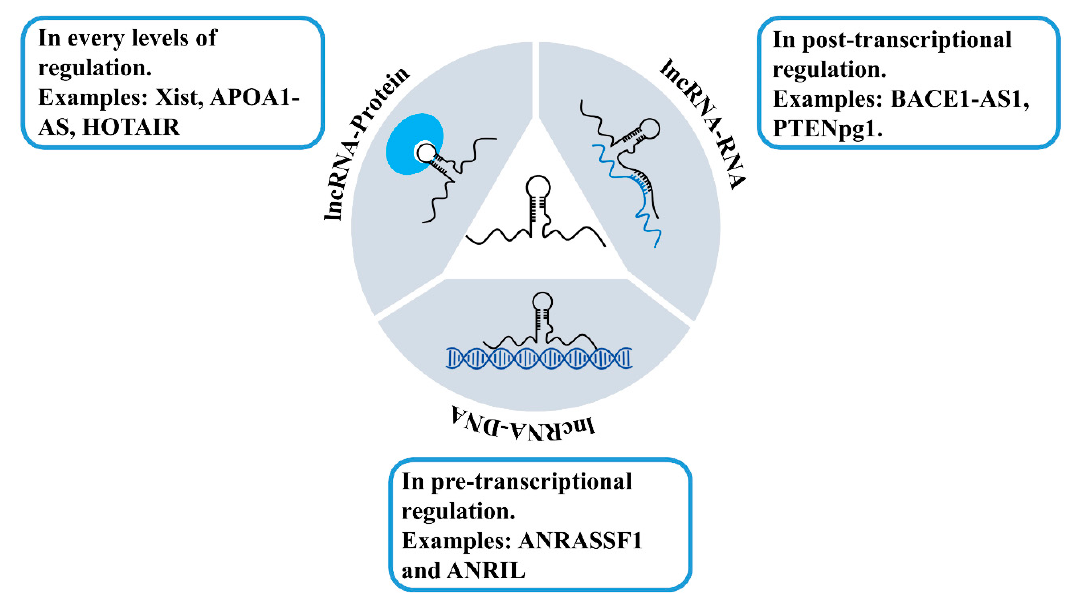
Figure 7. Examples of lncRNAs interacting with DNAs, RNAs, and proteins.